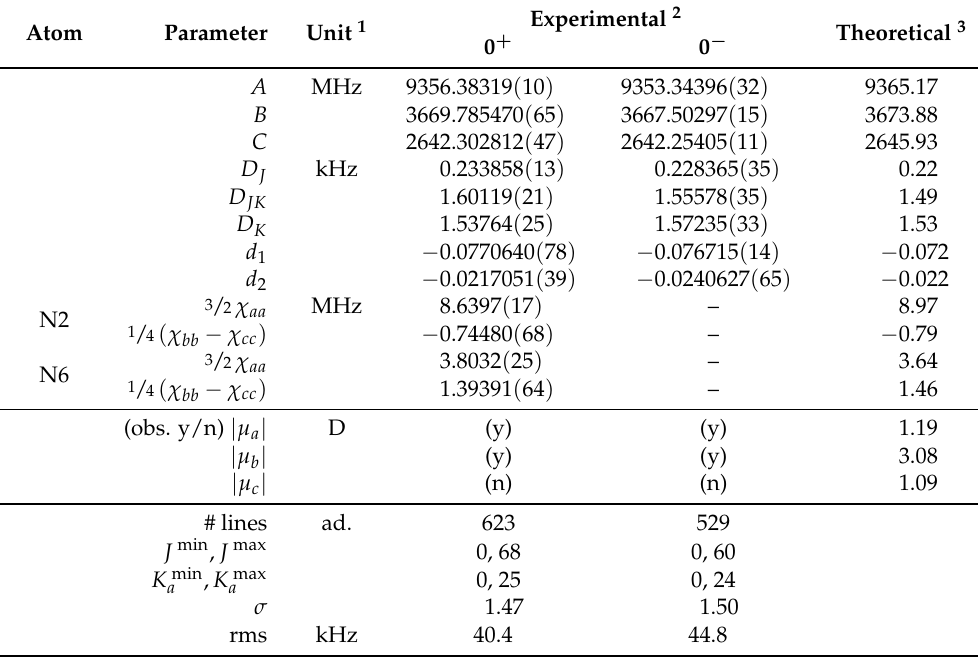
Table 2. Spectroscopic parameters and fit statistics for